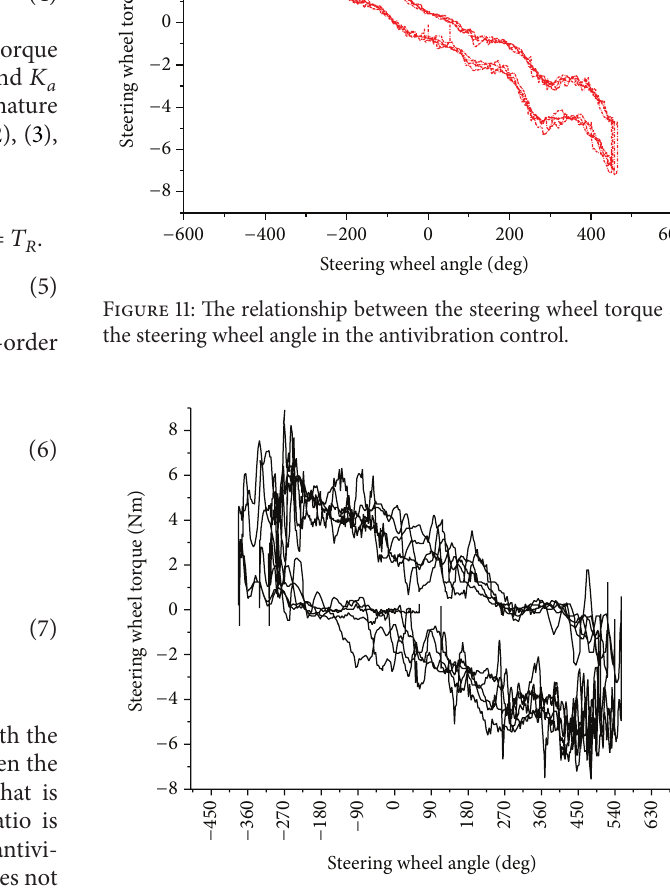
Figure 12: The relationship between the steering wheel torque and the steering wheel angle in the basic